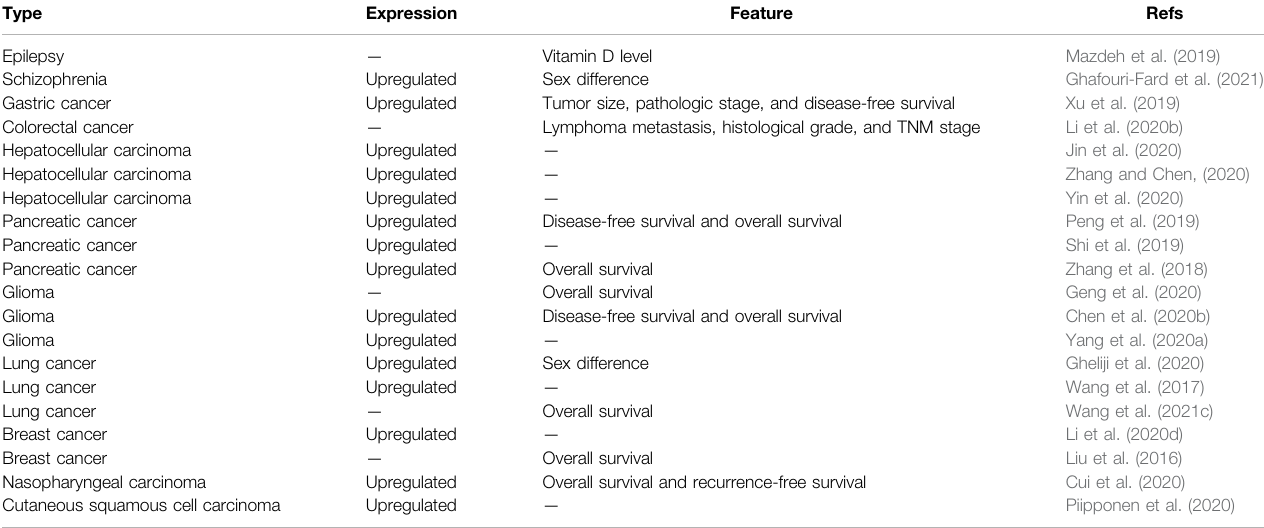
TABLE 1 | The expression and clinical features of LINC00346 in disease.